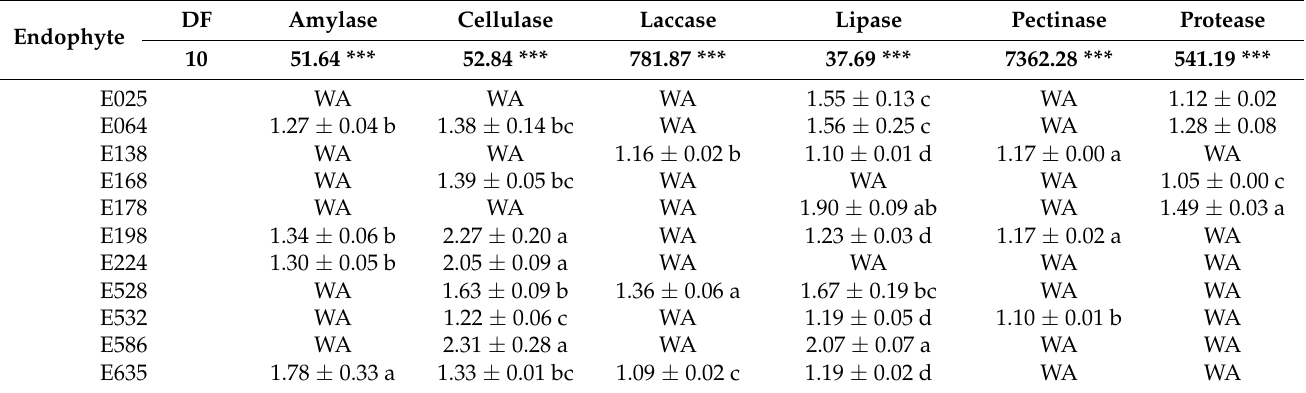
Table 2. Solubilization index (mean ± standard error) produced by each endophyte for each enzyme. A summary of the ANOVA, showing the effect of the endophyte, with the DF (degree of freedom) and F values, including the level of significance (*** p ≤ 0.001), indicated in the second row for each enzyme activity.